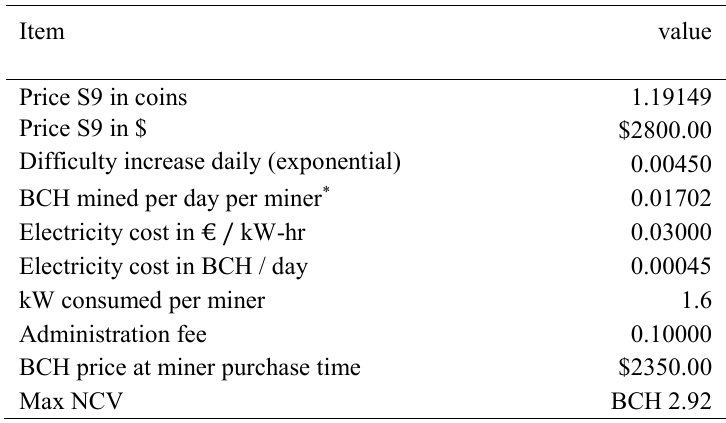
Fig. 2. Prepaying for machines with delays in delivery times has significant impact on profitability at 2016-2017 hashing capacity growth levels. Table 1. Bitmain Antminer S9 parameters